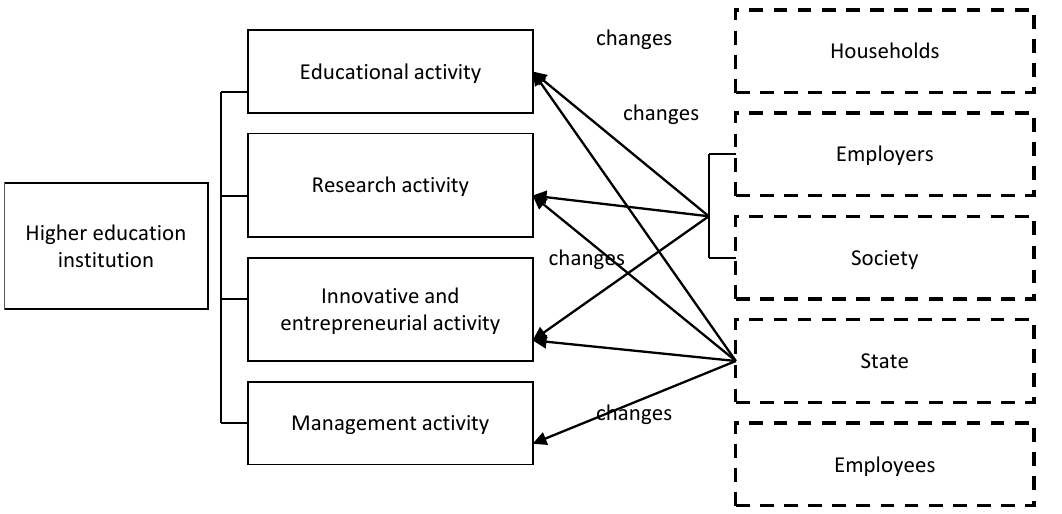
Figure 1. Influence of stakeholders on changes in the activity of higher education